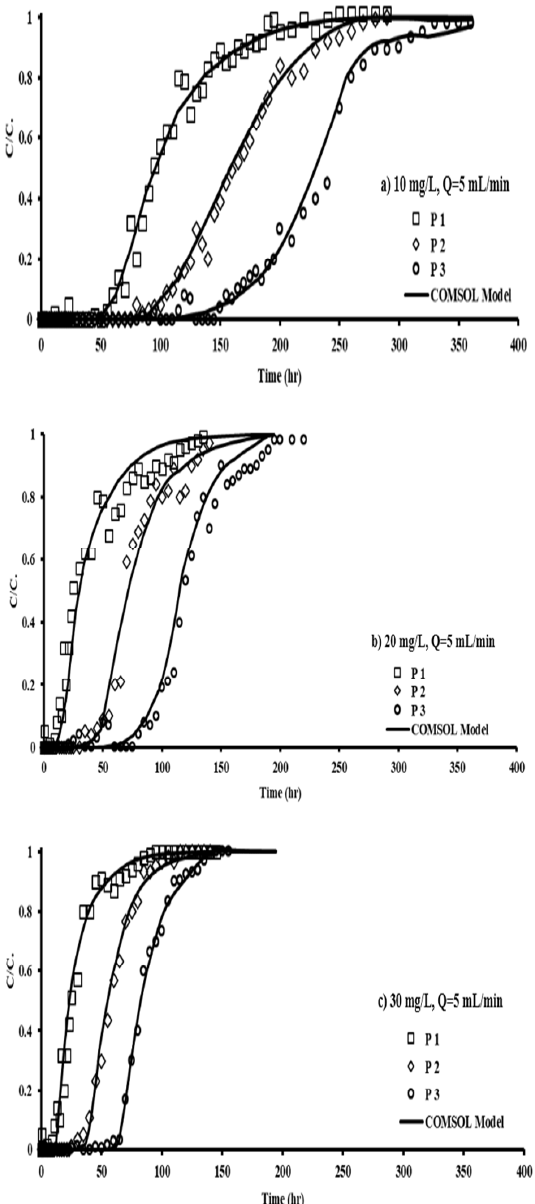
Fig. 4. Comparison between model predictions and experimental measurements for the normalized